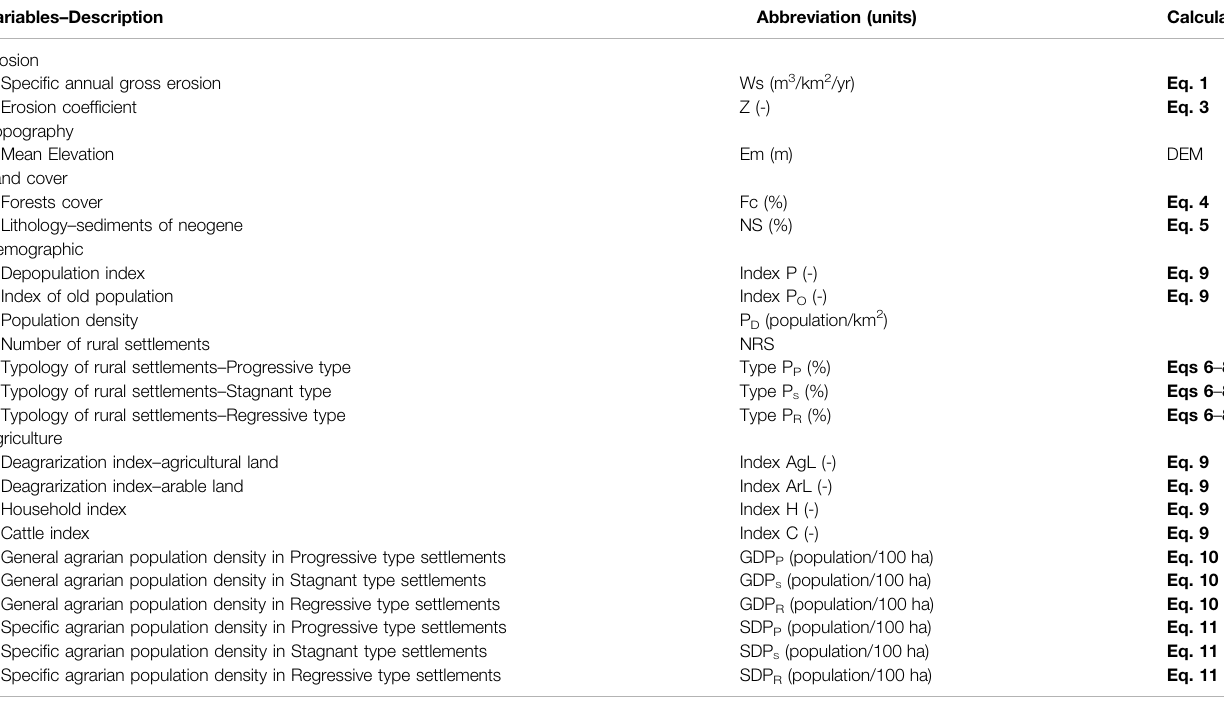
TABLE 2 | Controlling variables used in correlation and PCA analysis. Variables – Description